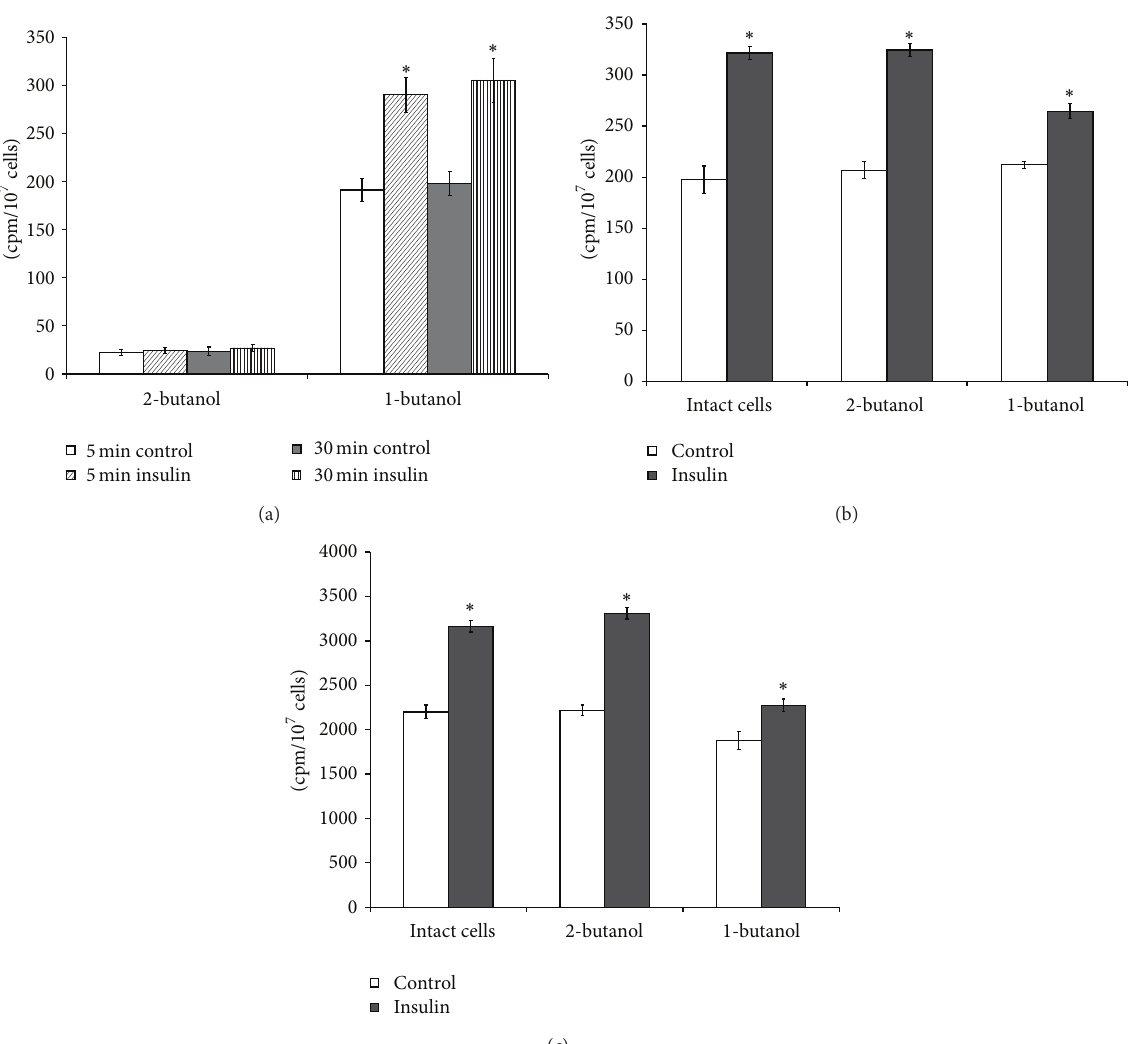
Figure 4: Effects of 1-butanol on phospholipase D activity and glucose metabolism stimulation by insulin in the isolated hepatocytes. (a) Phospholipase D activity, (b) uptake of 2-D-[ 3 H]glucose, (c) incorporation of D-[U 14 C]glucose into glycogen. Effect of insulin on phospholipase D activity and glucose metabolism in the 1-butanol- or 2-butanol-pretreated hepatocytes was determined as described in the Methods. ∗ 𝑝 < 0.05 , insulin versus control; ∗∗ 𝑝 < 0.05 , insulin + 1-butanol versus insulin + 2-butanol; ∗∗∗ 𝑝 < 0.05 , 1-butanol versus